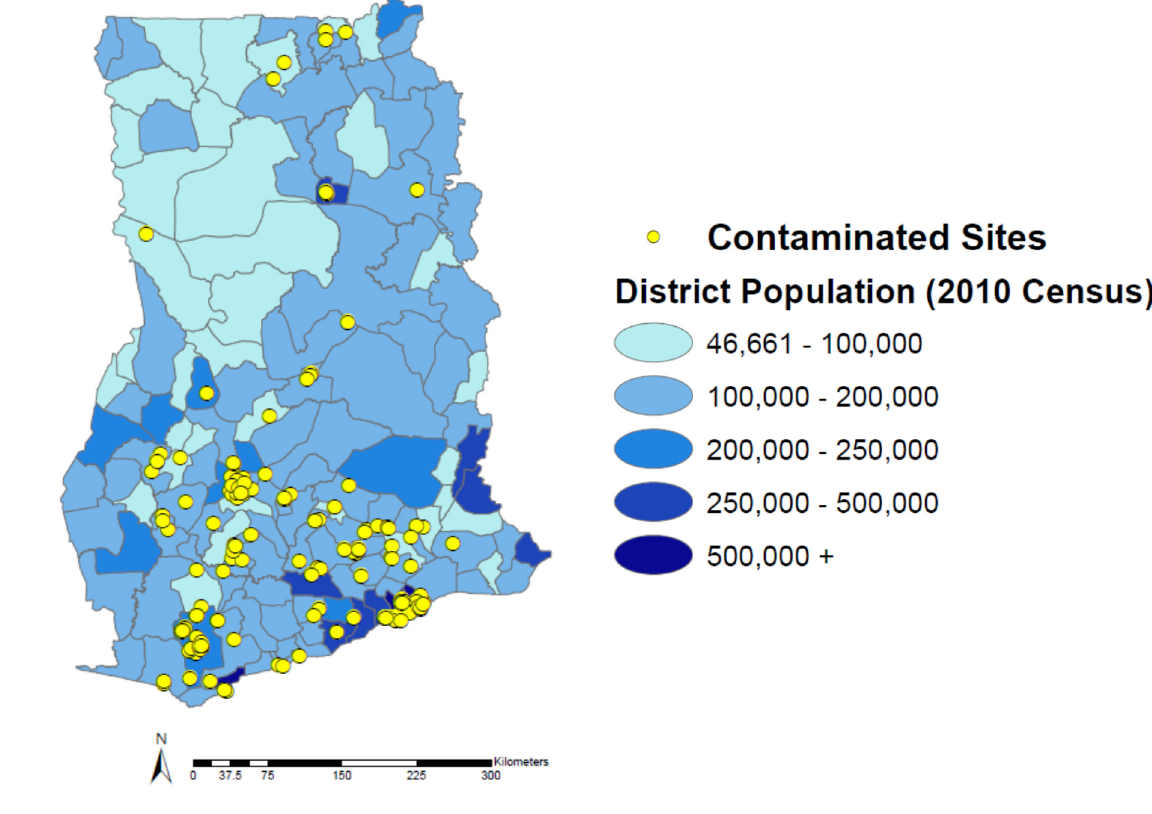
Figure 2. Population of Ghana by administrative district and contaminated